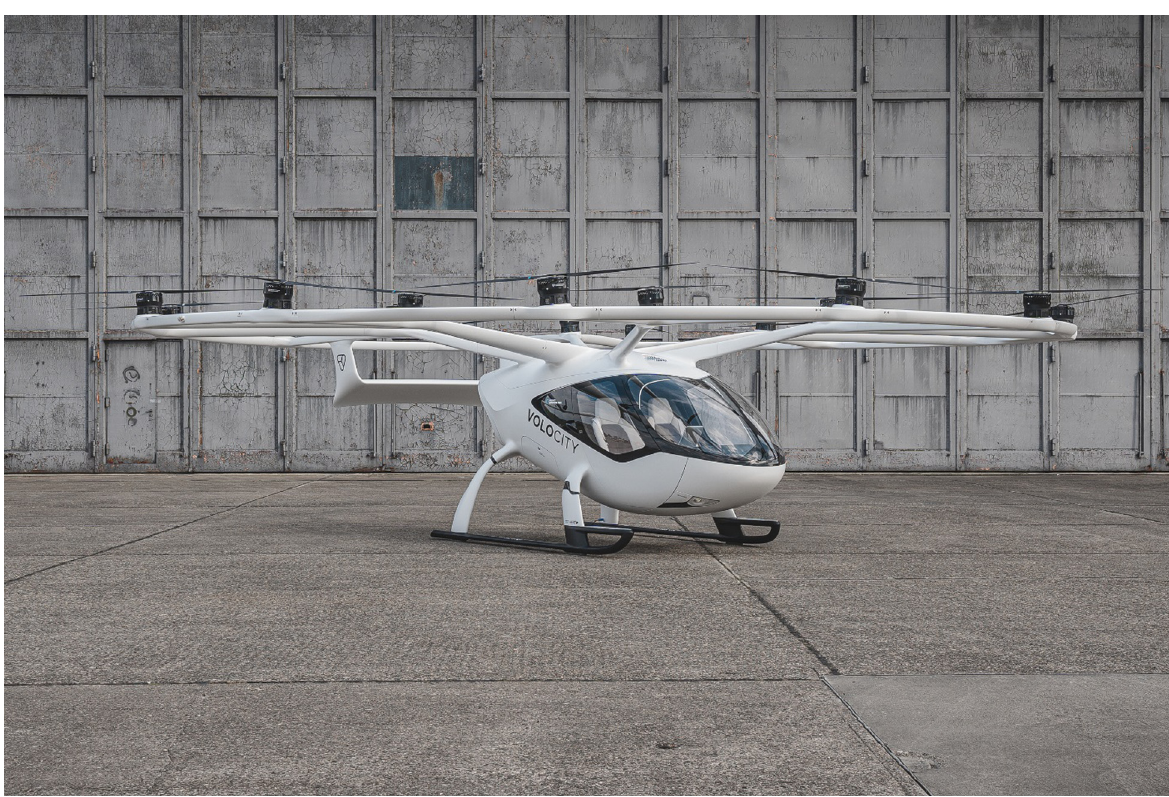
Figure 3: A real model of Volocopter ’ s VoloCity air taxi, aimed for commercial UAM services ( image credit: Volocopter GmbH, used with permission )